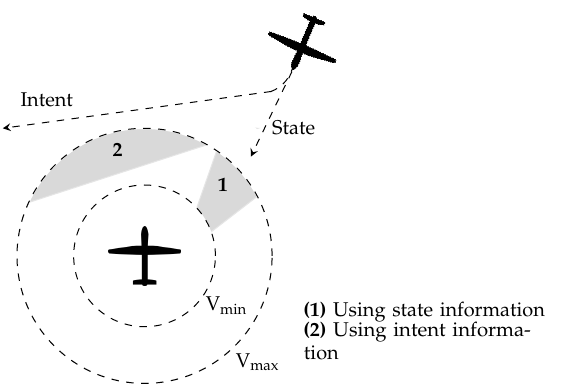
Figure 8. Shape of the VO depending on whether state or intent information is used to propagate the current trajectory of the intruder into the future.